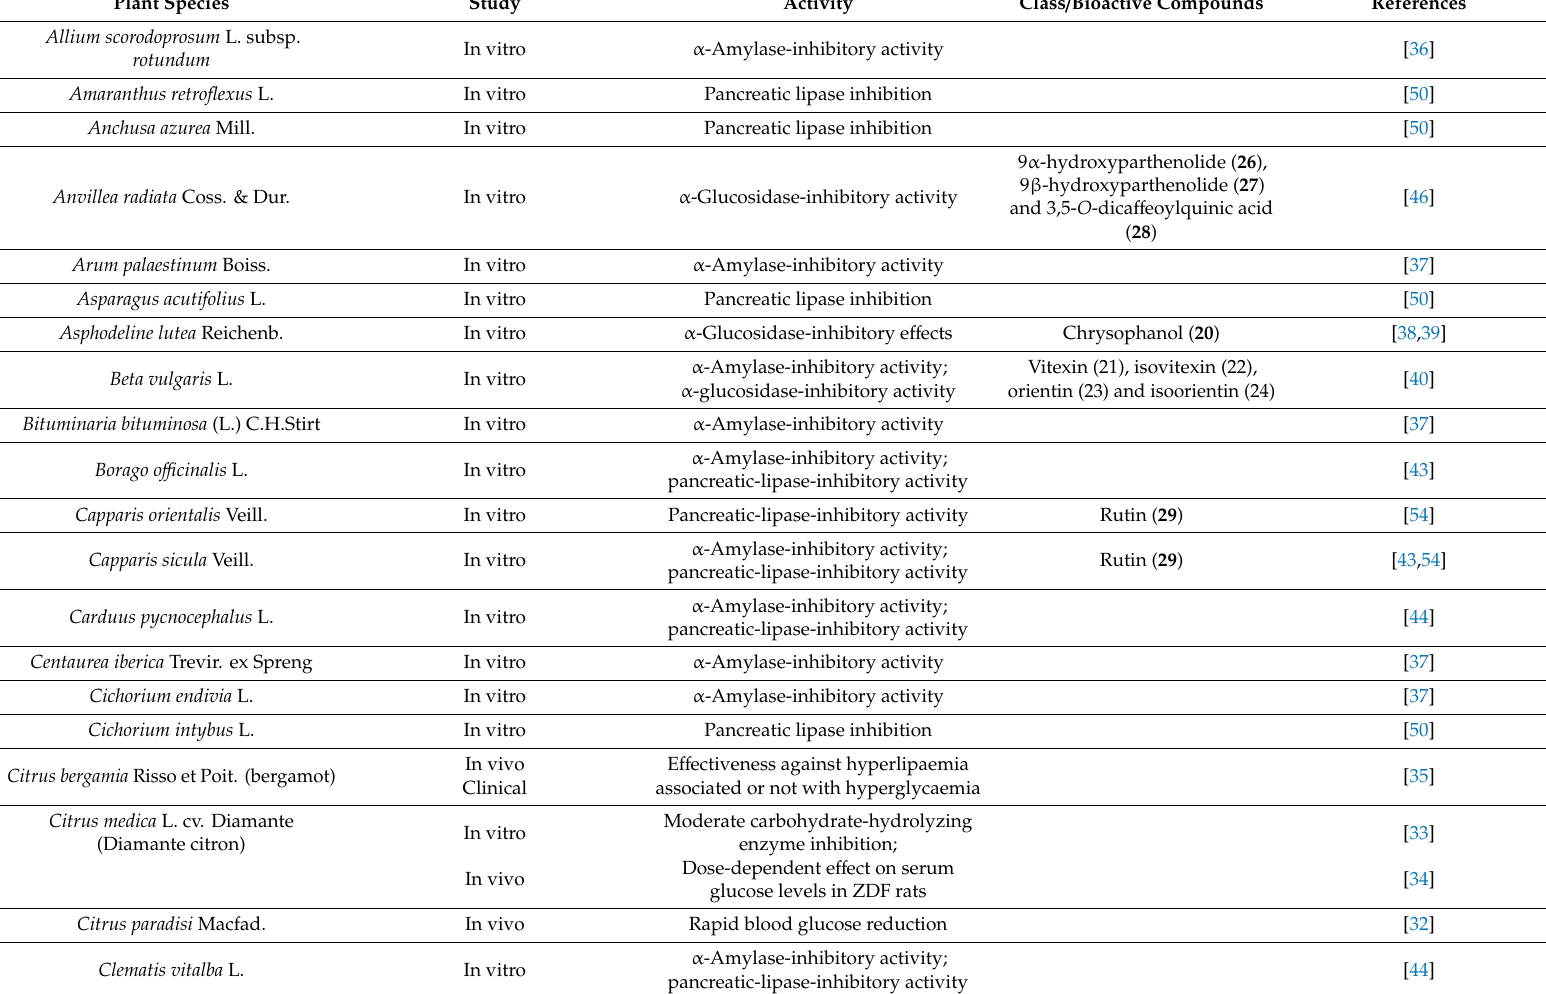
Table 1. Extracts from Mediterranean wild edible plants with beneficial e ff ects against obesity and related comorbidities. Plant